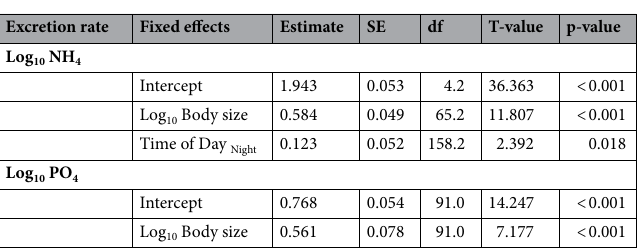
Table 3. Fitted parameters of the final selected model for N and P excretion